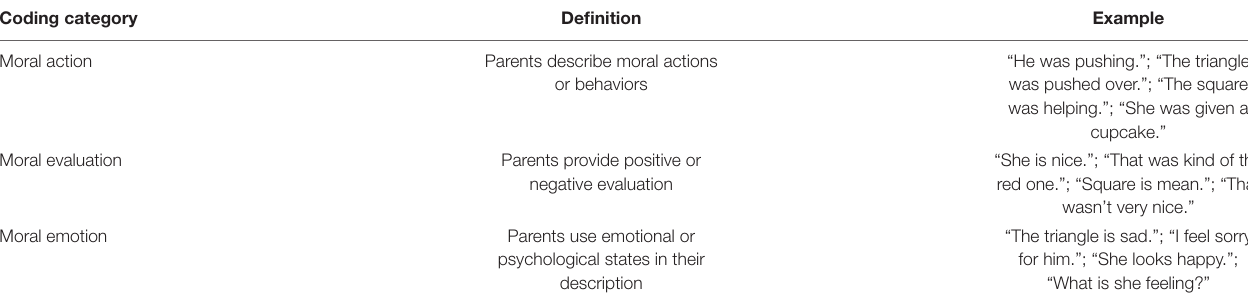
TABLE 1 | Parental moral speech focus coding category, definition, and example. Coding